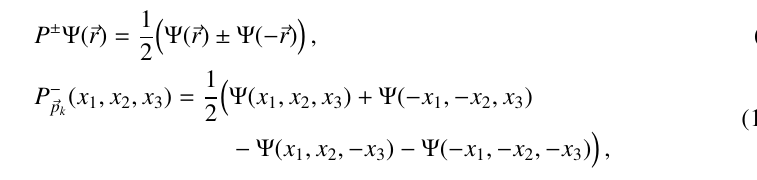
Figure 2: Figures from Ref. [1]. Left: as in Fig. 1 but with N = 128. The wavefunction from the kinetic terms H (0) and H (1) are almost indistinguishable [1]. K K Right: relativistic kinetic term H (3) with the modified harmonic oscillator potential (Ref. [24]) K momentum space wavefunctions with the relativistic kinetic term H (3) √ 4 π p Ψ ( p ) in order to compare to the theoretical predictions following